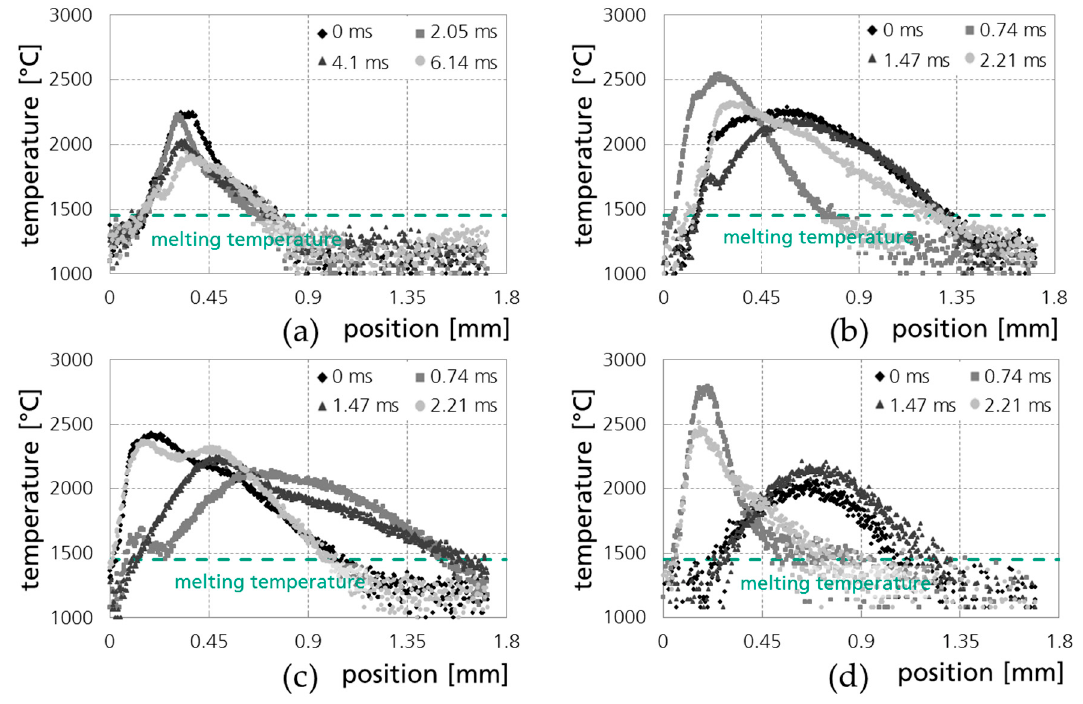
Figure 14. Spatially resolved temperature profiles T i (t) calculated with e = 1 along the symmetry axis of the cut front for four measurement moments of 12 mm stainless steel cut with the following parameters: ( a ) Set #1: Static beam shaping with 488 fps; and different values of the longitudinal, linear beam oscillation parameters with 1360 fps: ( b ) Set #2: 300 µm amplitude and 500 Hz frequency; ( c ) Set #3: 550 µm amplitude and 500 Hz frequency; ( d ) Set #4: 300 µm amplitude and 2000 Hz frequency.